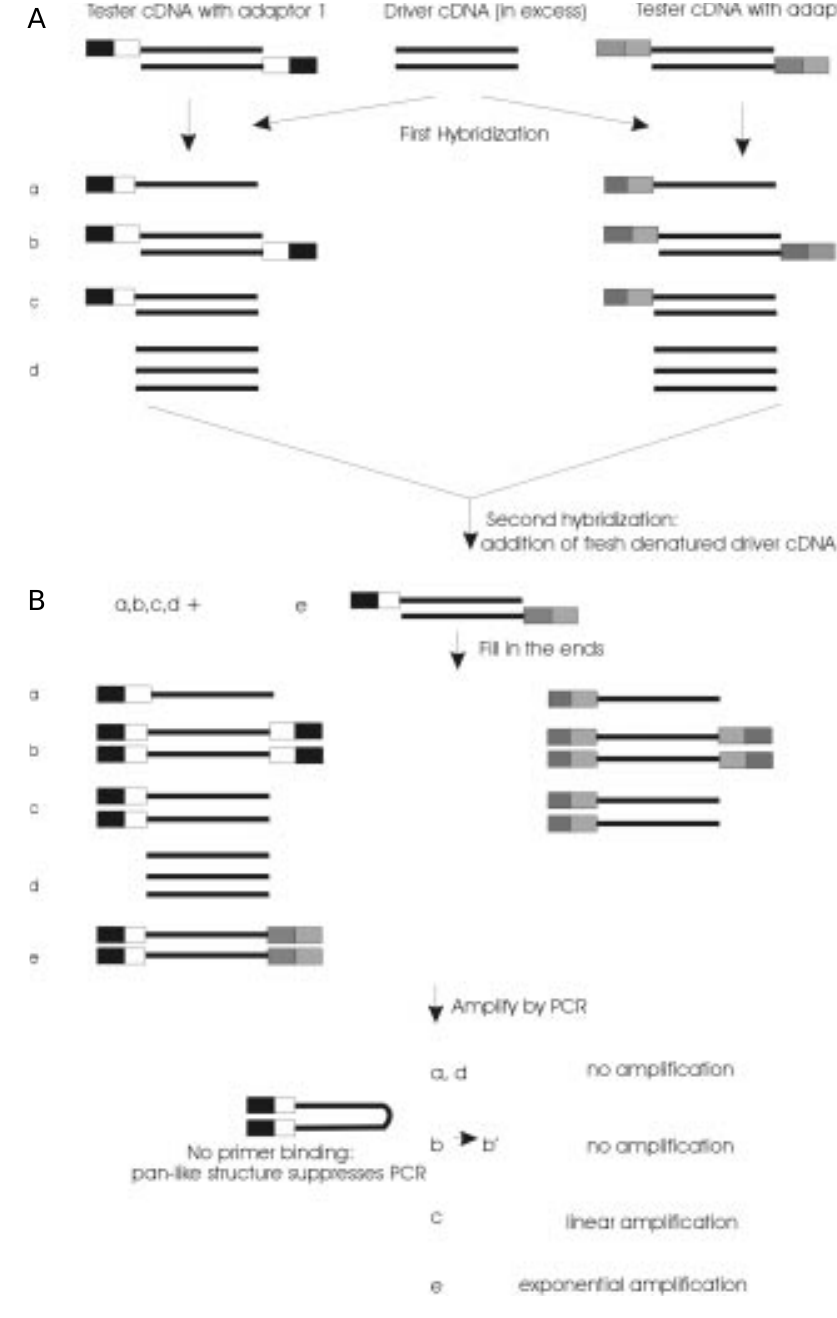
Figure 1 - Schematic diagram of the cDNA subtraction procedure using the PCR suppression ef- fect (18). Boxes represent the outer and inner portions of adap- tors 1 and 2. Solid lines repre- sent the Rsa I-digested tester or driver